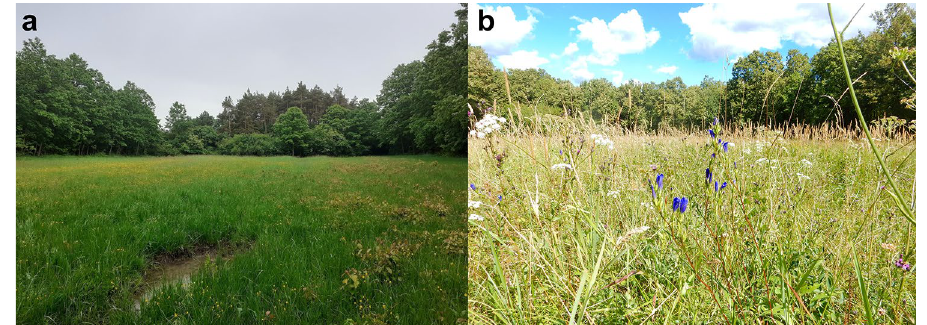
Figure 2. The field site at Gyilkos-rét where Myrmica scabrinodis nests and Phengaris alcon eggs and caterpillars were collected. ( a ) Early June. ( b ) Mid-August with flowering Gentiana pneumonanthe in the central foreground. See Fig. 5 in Csősz et al. 29 for maps of the locality. Photo: András Tartally ( a ) and Márton József Paulin ( b ).